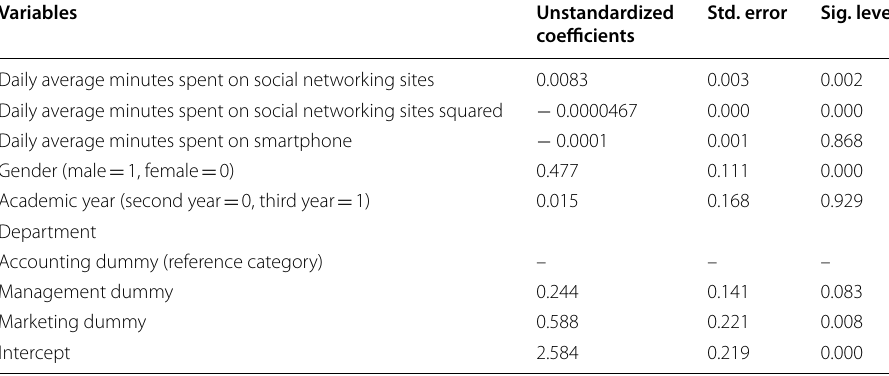
Model summary: No of observations